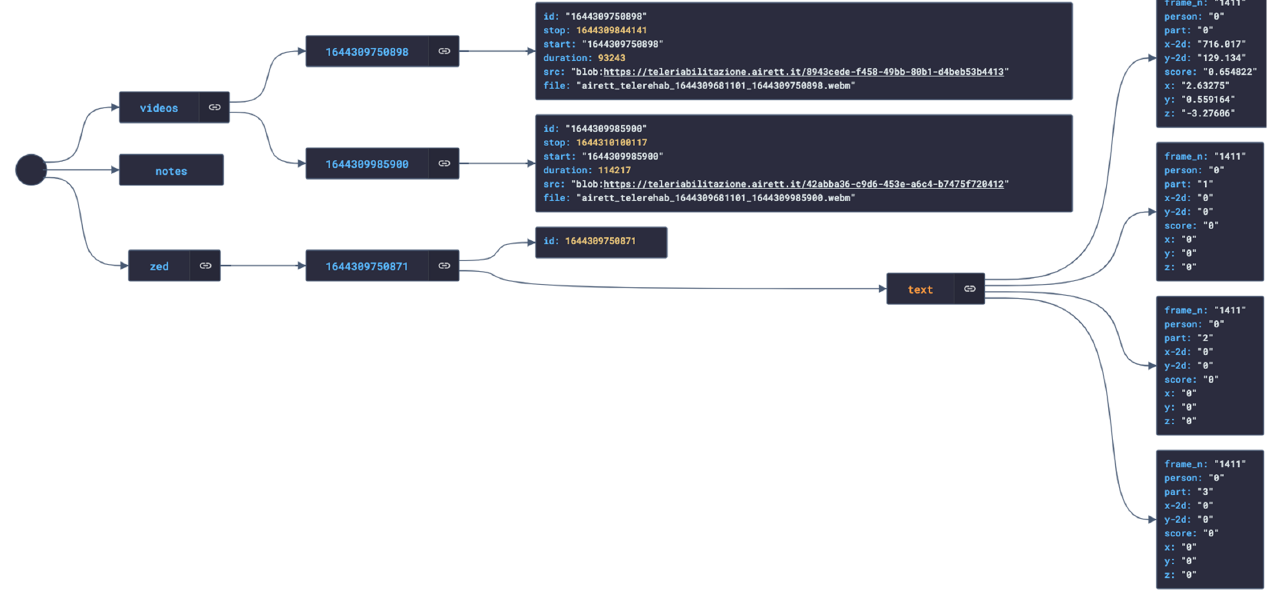
Figure 4. A graph representation of the JSON file storing data and metadata about a therapy session.